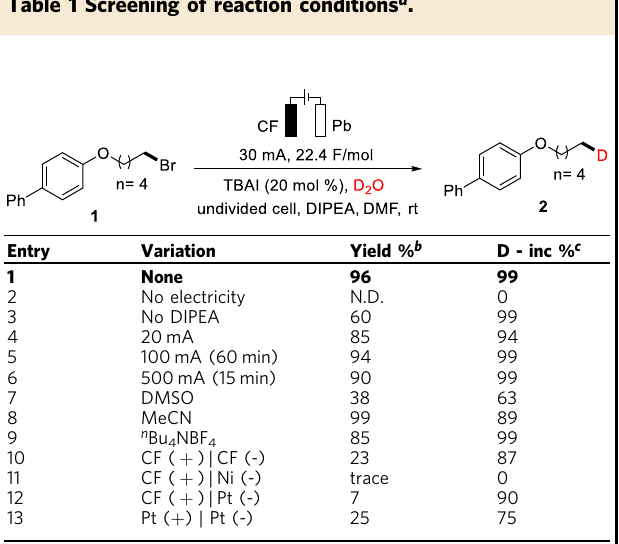
Table 1 Screening of reaction conditions a .